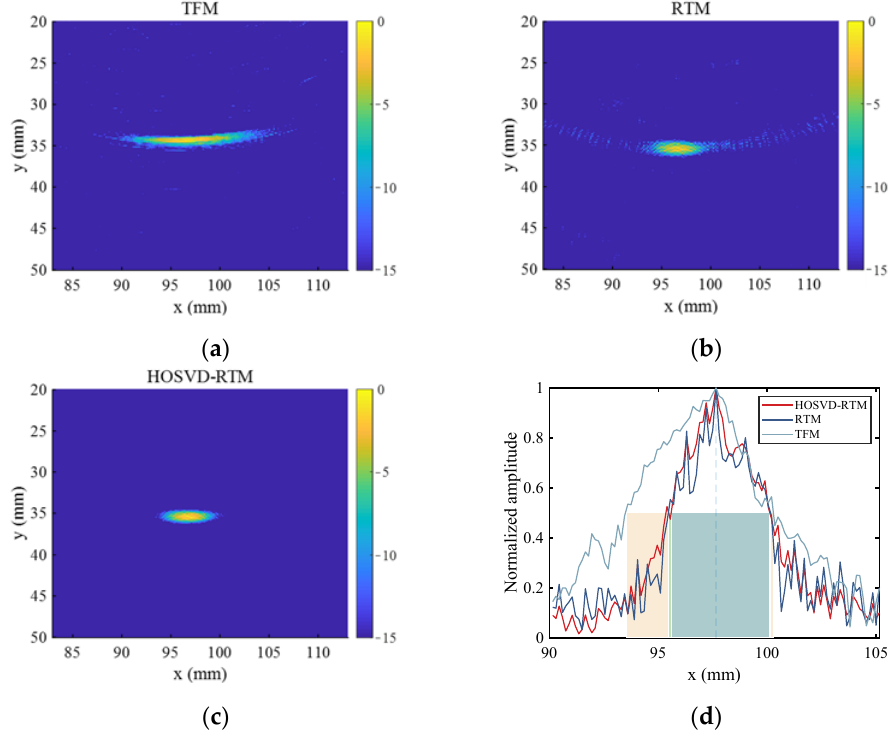
Figure 12. Imaging results obtained with the array composed of 8 elements and different algorithms (( a ) TFM, ( b ) RTM, ( c ) HOSVD-RTM)); ( d ) cross-sectional view of defect location. Table 2. Image SNR and lateral width of − 6 dB of different imaging results. Number of Array Measurement Measurement Content Elements